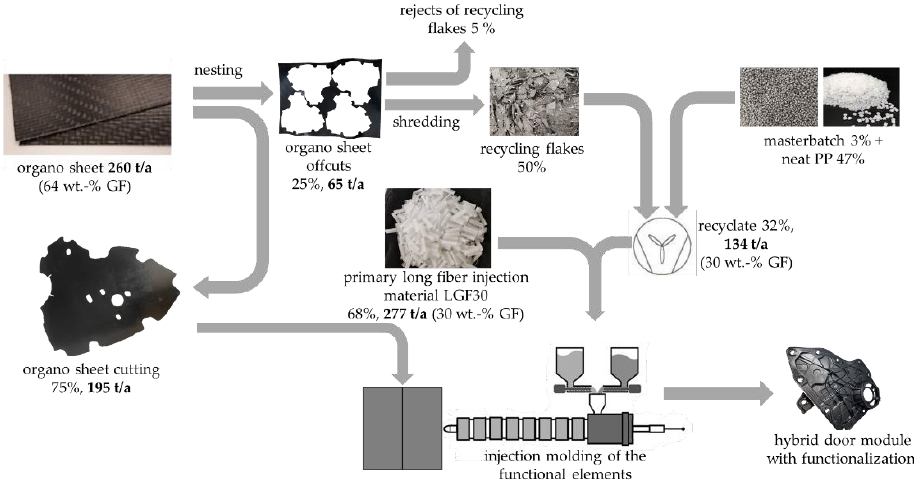
Figure 3. Recycling process and mass flows in the production of a hybrid door module considering closed-loop recycling of organo sheet offcuts.